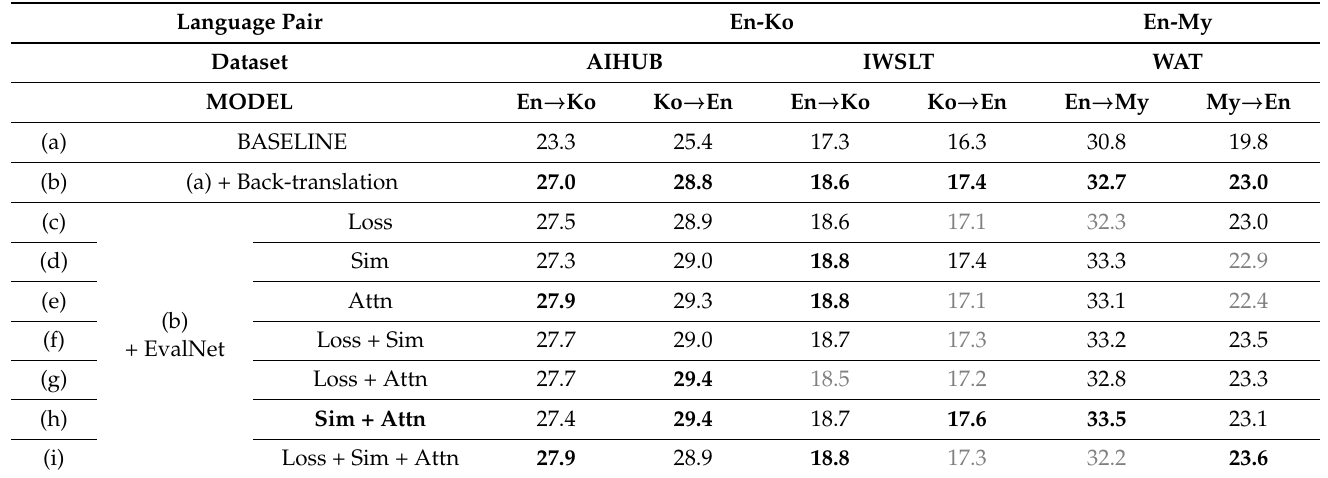
Table 4. Performance comparisons of EVALNET according to the features. The numbers in gray indicate performance degradation compared to the results of